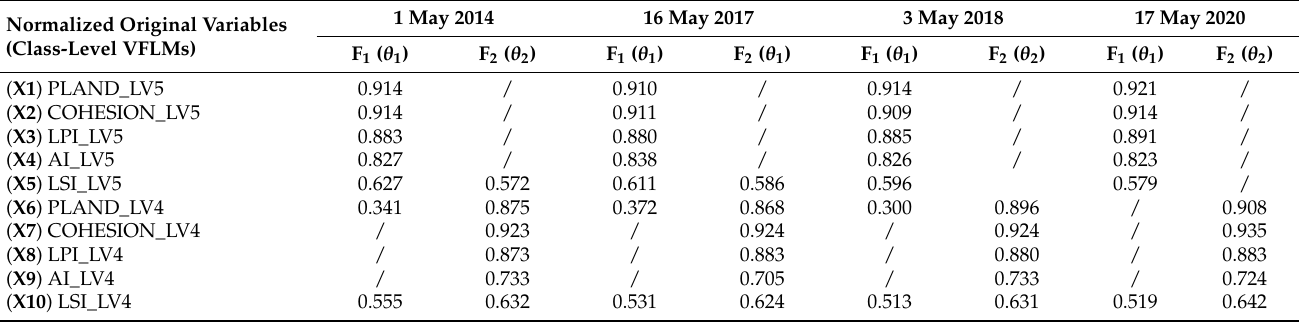
Table 7. Component matrix of principle component analysis 1 (cid:13)